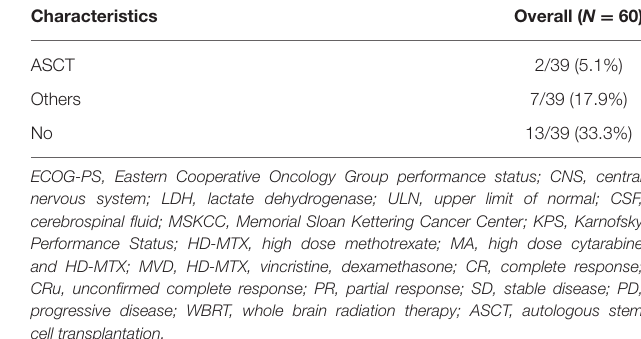
TABLE 1 | Baseline characteristics of patients with PCNSL.